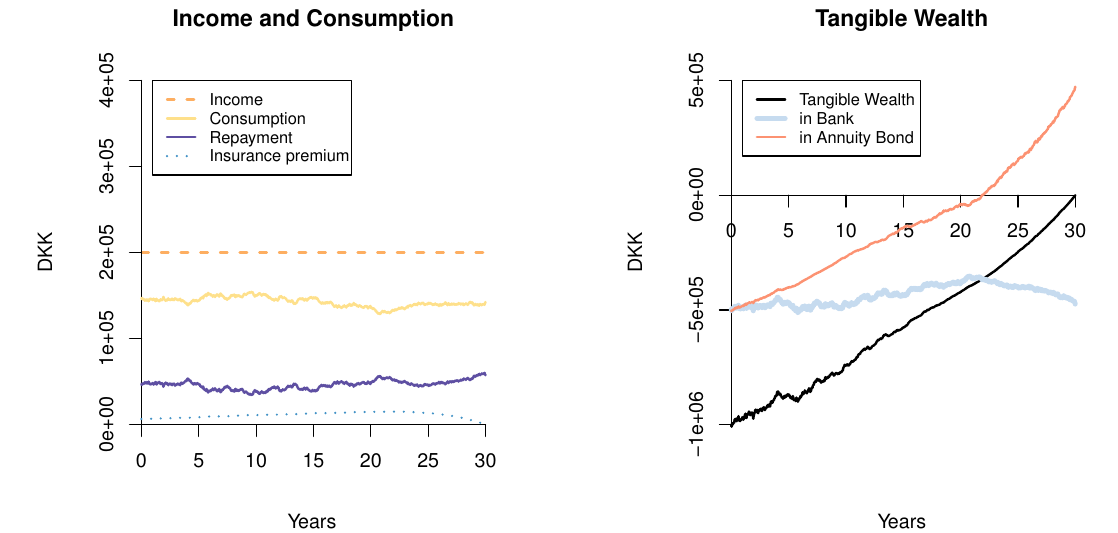
Figure 3. Moderate investor with constant income in the regular market with mortality risk.